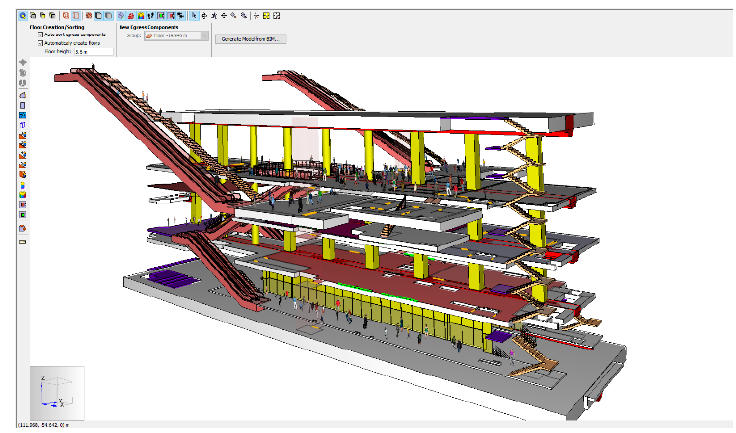
Figure 6. Simulation model with occupants.